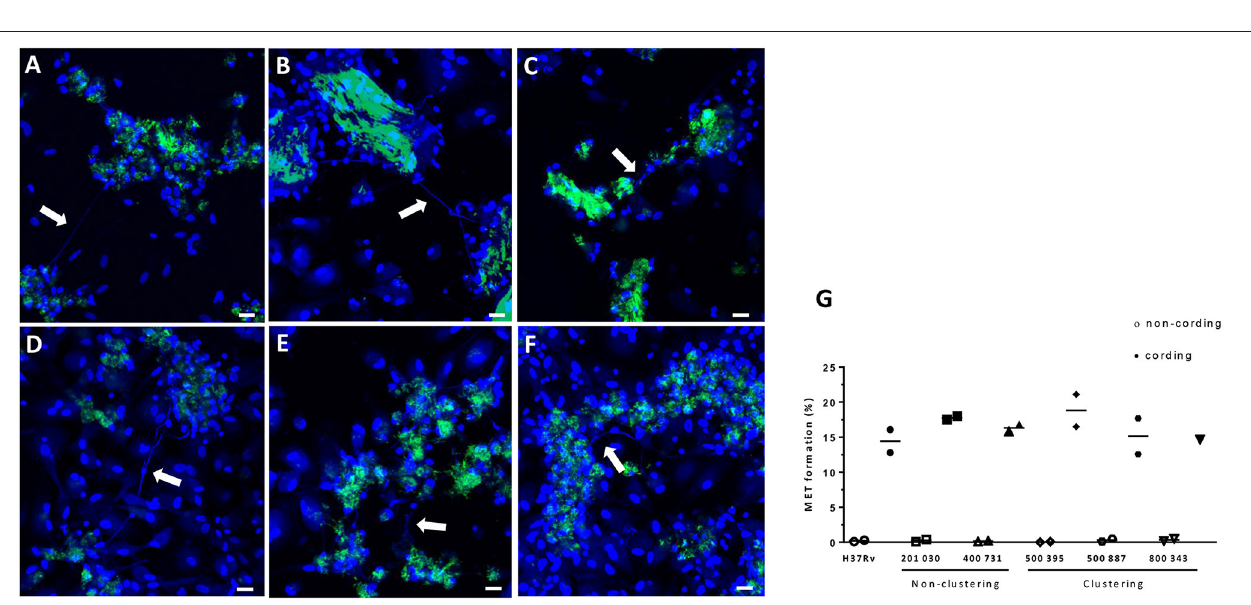
FIGURE 8 | H37Rv and five clinical strains cultured under shaking conditions/Tween low induce MET formation. GFP-expressing (green) M. tuberculosis were passaged and cultured in the presence of 0.01% Tween for 3 days on a shaker at 260 rpm. Macrophages were infected at a MOI of 10 with (A) H37Rv, (B) 201 030, (C) 400 731, (D) 500 395, (E) 500 887, and (F) 800 343. DNA was visualized with DAPI (blue). The white arrows indicate METs released the macrophages. Bar: 20 µ m. (G) The percentage of cell nuclei producing METs 24 h after infection. Mean values of METs production are shown for each donor individually ( n = 2).